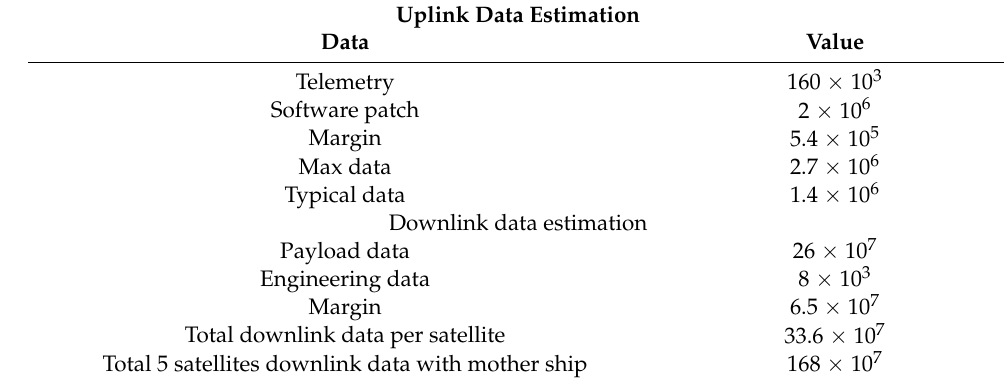
Table 2. Estimated Up/Down link data